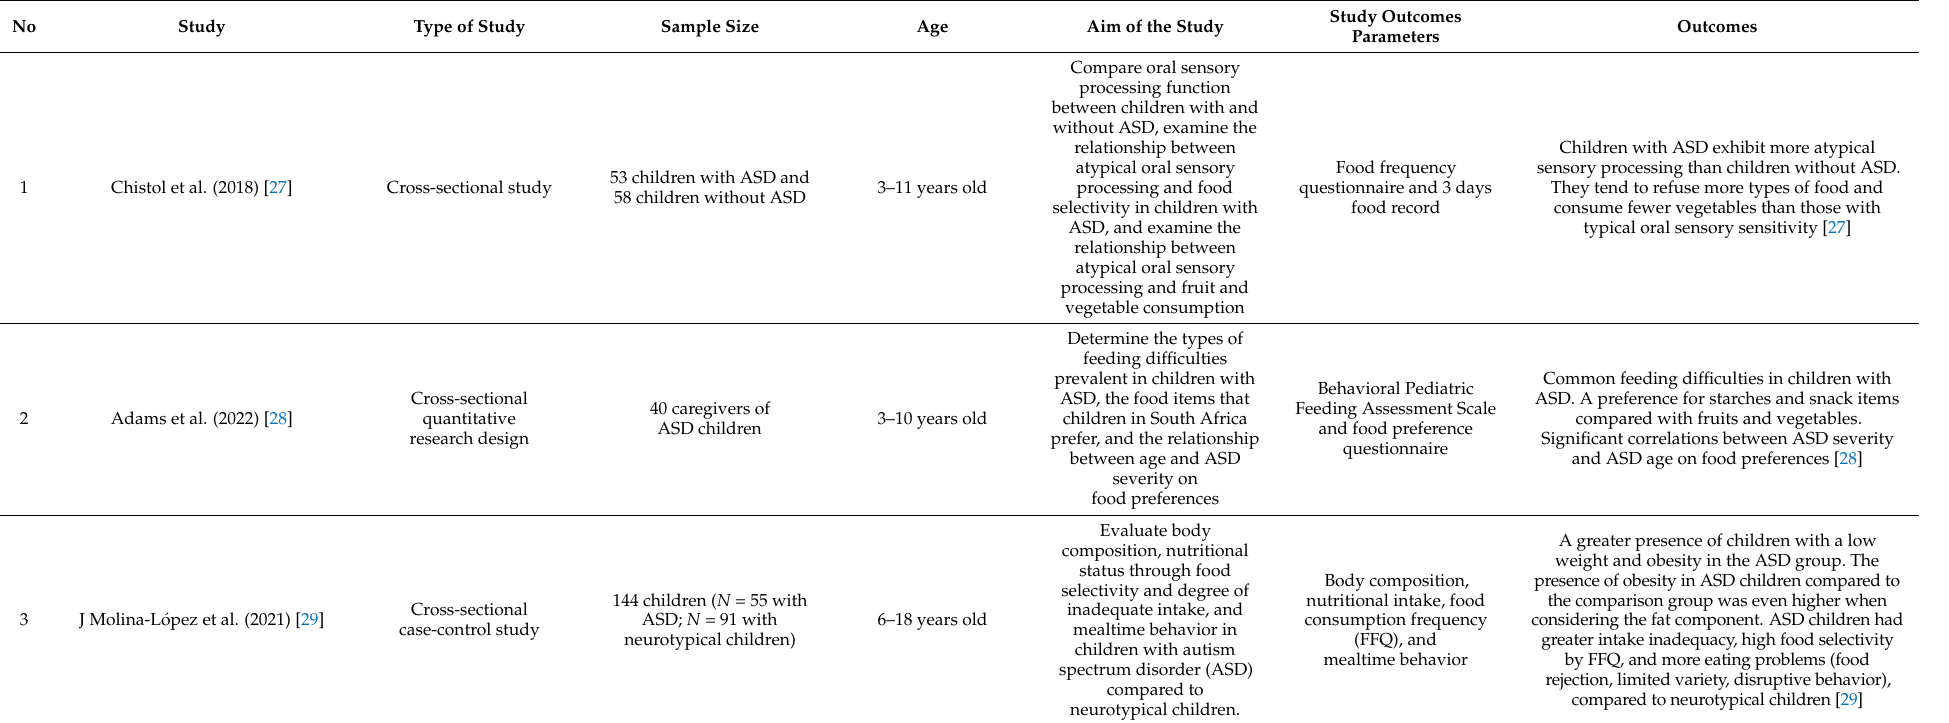
Table 2. Studies on the poor dietary intake of ASD